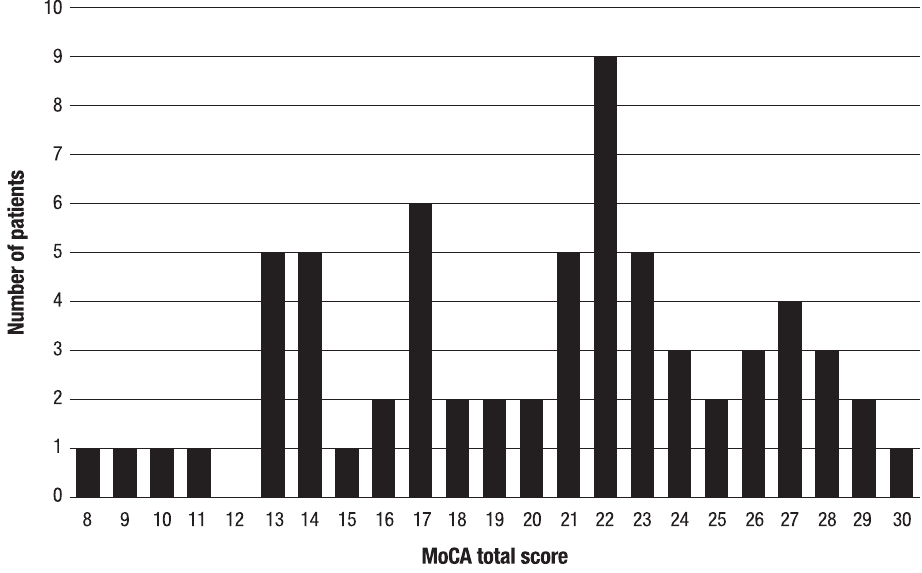
Figure 1. Graph showing distribution of total MoCA scores in the sample of 66 Brazilian patients with PD. Total scores were approximately normally distributed with a wide range of scores and only one patient obtaining the maximum score and none obtaining the minimum score.